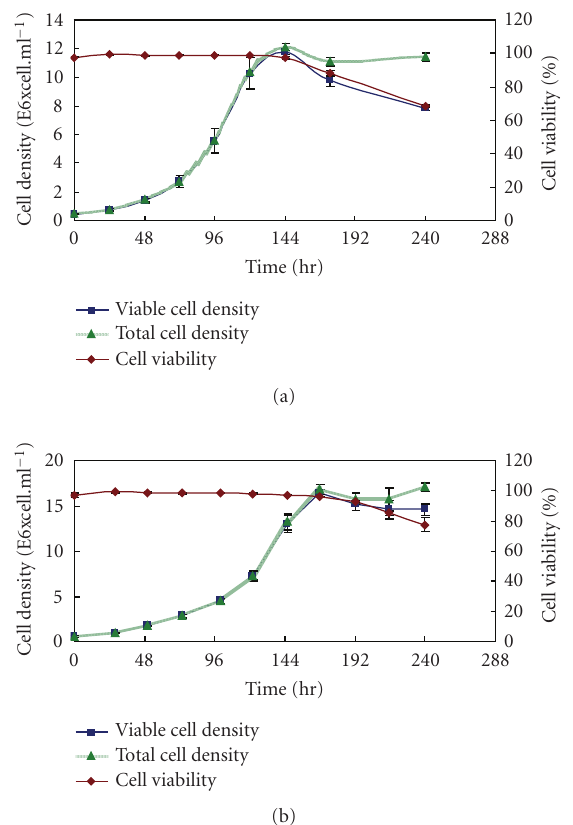
Figure 4: Growth curve of the stably transfected Sf9 producing hIL- 7 and nontransfected Sf9 insect cells. (a) Viable cell density, total cell density, and viability of stably transfected Sf9 with pIZ/V5-hIL- 7 plasmid. Cells were seeded at a density of 5 × 10 5 cells · mL − 1 and maintained at 1 × 10 7 cells · mL − 1 . (b) Viable cell density, total cell density, and viability of nontransfected Sf9 insect cells. Cells were seeded at a density of 5 × 10 5 cells · mL − 1 ( n = 3).